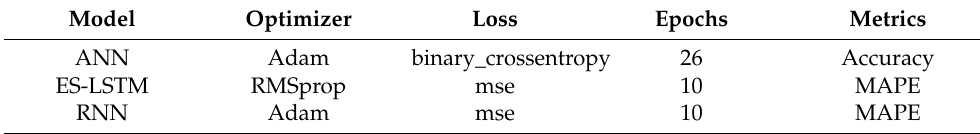
Table 4. The used configuration parameters for ANN, ES-LSTM, and RNN models.